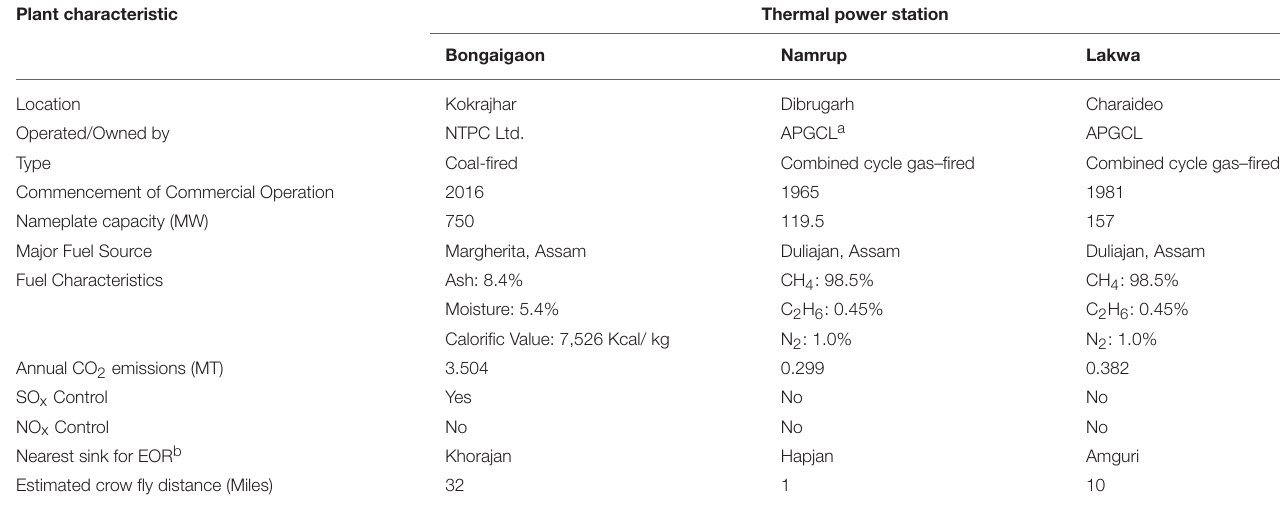
TABLE 2 | Plant performance parameters in assam (Carbon Capture and Storage Association, 2011b; Sharma and Mahapatra, 2018). Plant